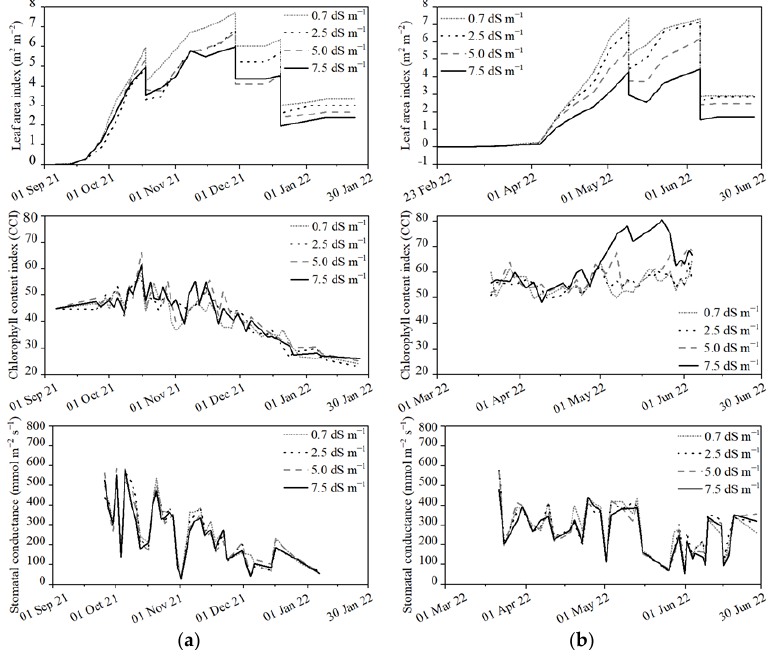
Figure 5. Changes in leaf area index, chlorophyll content index, and stomatal conductance values under different water salinity levels throughout the growing seasons; ( a ) autumn 2021 and ( b ) spring